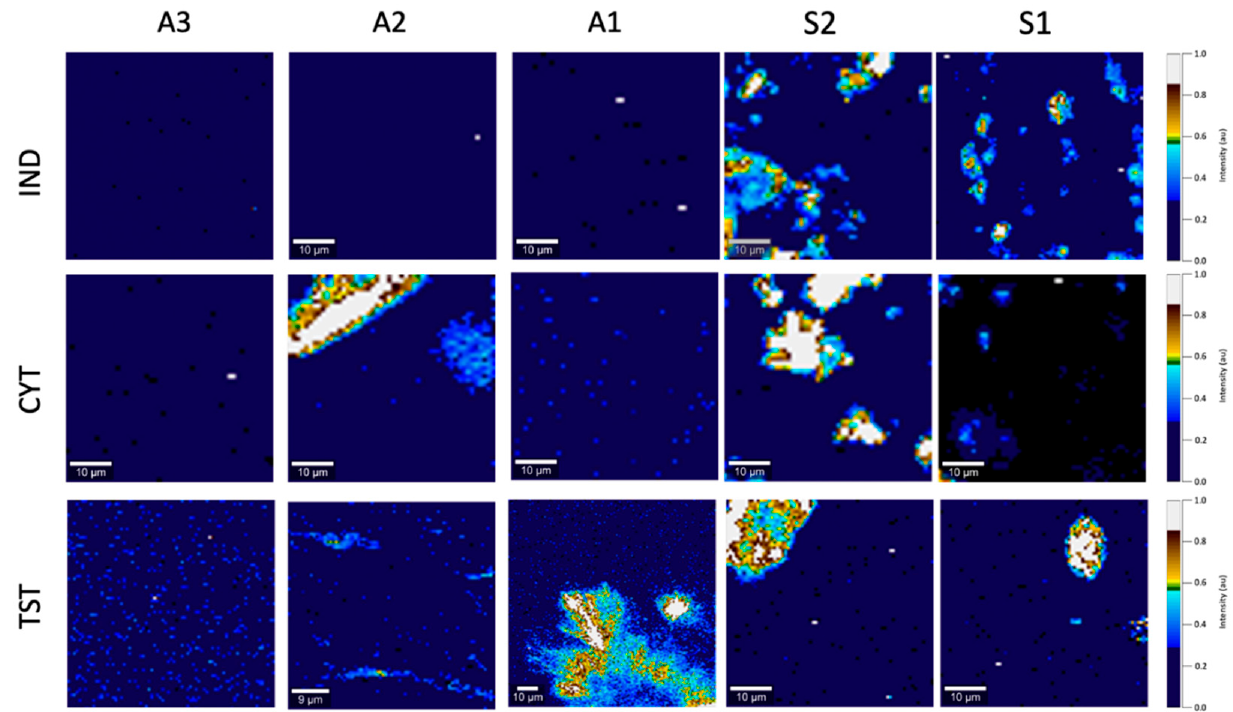
Figure 6. Raman image of indomethacin (IND), cytisine (CYT) and testosterone (TST) distribution on the surface of acrylate (A) and silicone (S) patches (scale 10 µm).